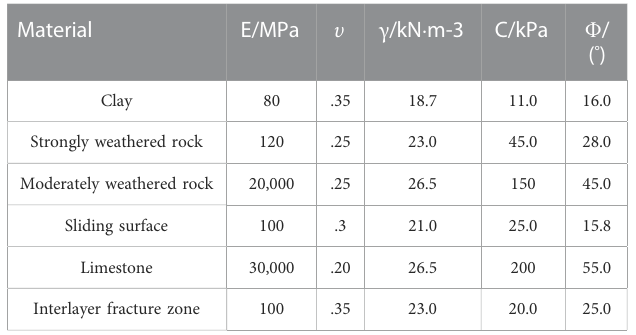
TABLE 1 Physical and mechanical